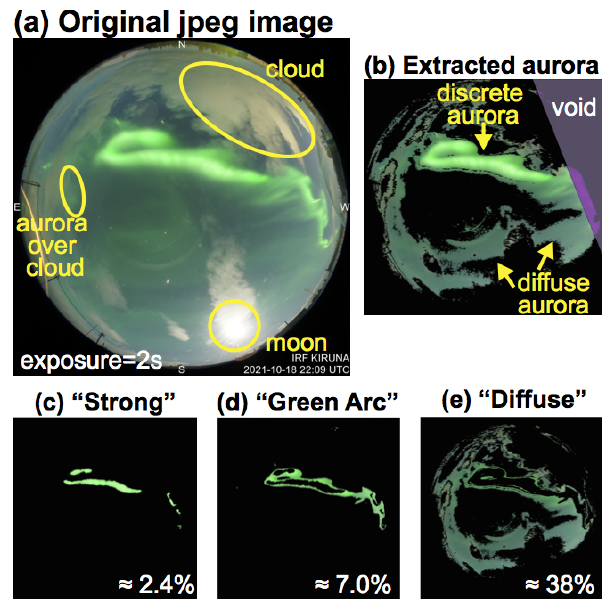
Figure 1. The all-sky image and processed images of 18 Octo- ber 2021, 22:09UT, taken by the Kiruna all-sky camera (ASC). The automatic exposure time for this particular image is 2s (second- shortest due to the Moon). Aurora pixels are characterized by green color (its emission is at the 558nm wavelength, but that is not re- solved in the RGB system). (a) ASC image before the analysis (low-resolution JPEG with 482 × 482 pixels) that is shrunk from the original image (2832 × 2832 pixels). Basic categories of aurora (discrete and diffuse), cloud, and the Moon are marked in the fig- ure. (b–e) Processed images by the automatic identification of each pixel (present method), extracting (b) all aurora pixels (window is 430 × 430 pixels), (c) only the “strong aurora” in the present defini- tion, (d) only the “green arc”, and (e) only “visible diffuse”. In the analysis, we mask all pixels at more than 215 pixels from the center and also the upper right corner (purple-shaded region in b ) because this part is normally contaminated by city light (located to the west of the